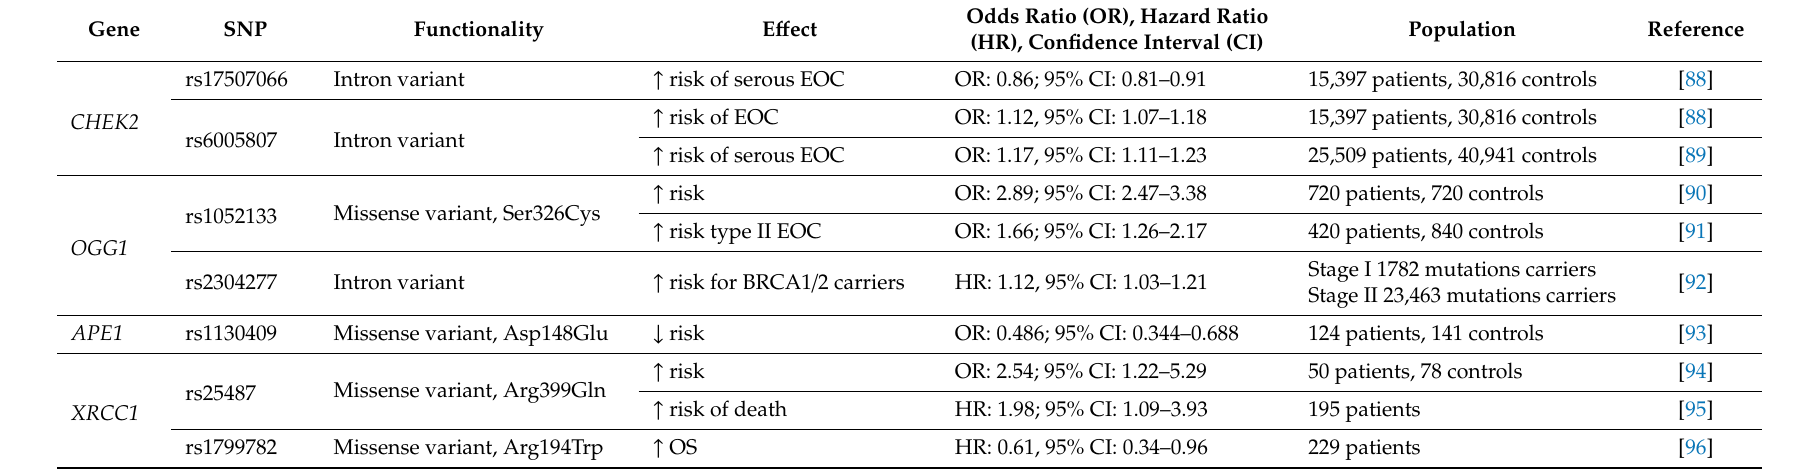
Table 1. List of OvC-associated SNPs. Symbols: ↑ means higher, or better; ↓ means lower. Gene names: checkpoint kinase 2 ( CHEK2 ), 8-oxoguanine DNA